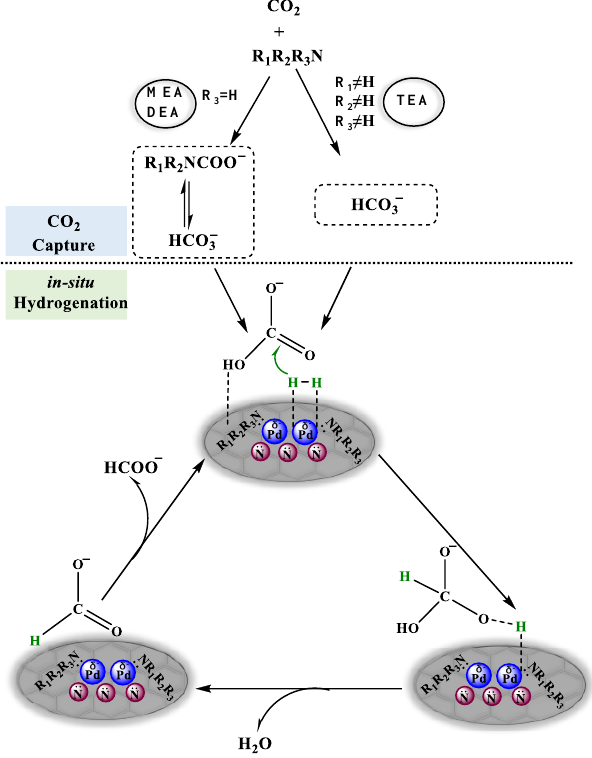
Figure 4. Scheme of reaction mechanism of integrated CO 2 capture and hydrogenation in aqueous amine solutions catalyzed by Pd/NAC.